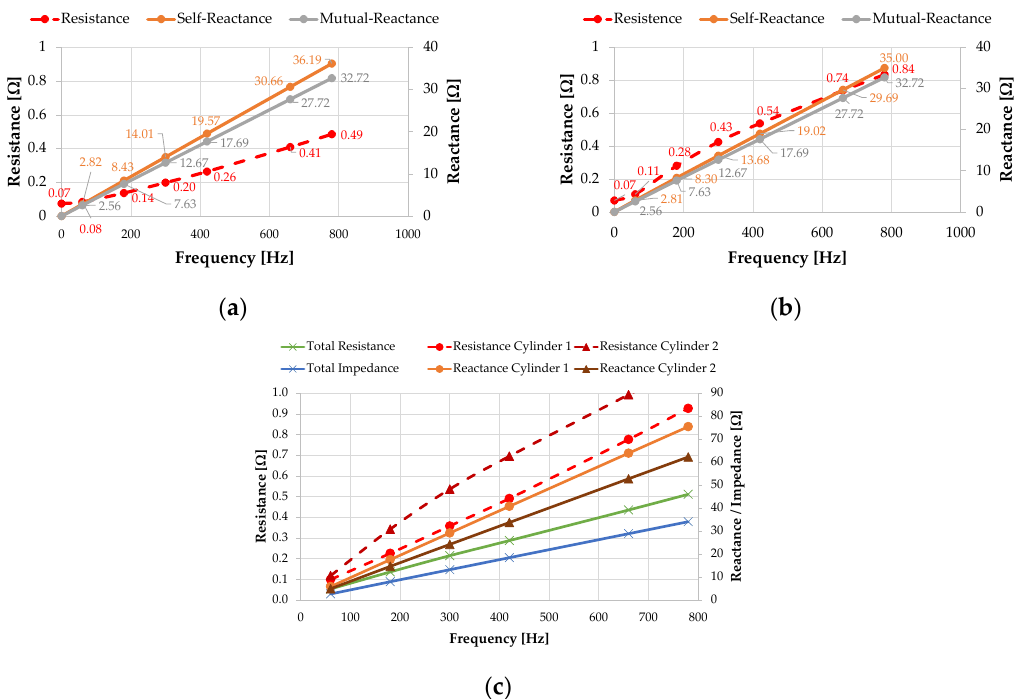
Figure 16. Resistance and reactance values of the air-core reactor: ( a ) Cylinder 1; ( b ) cylinder 2; ( c ) values considering skin and proximity e ff